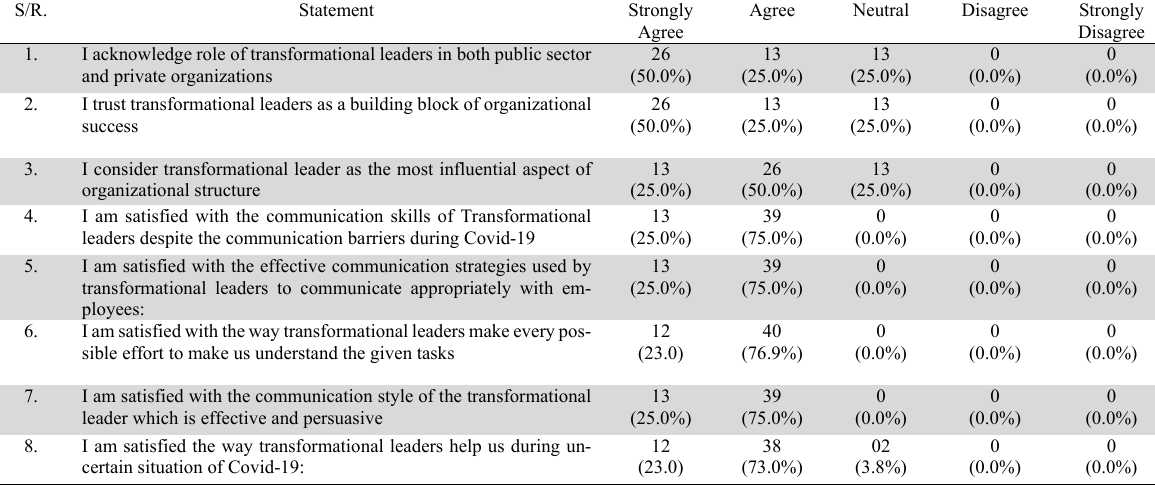
Frequencies and Percentages of the Responses